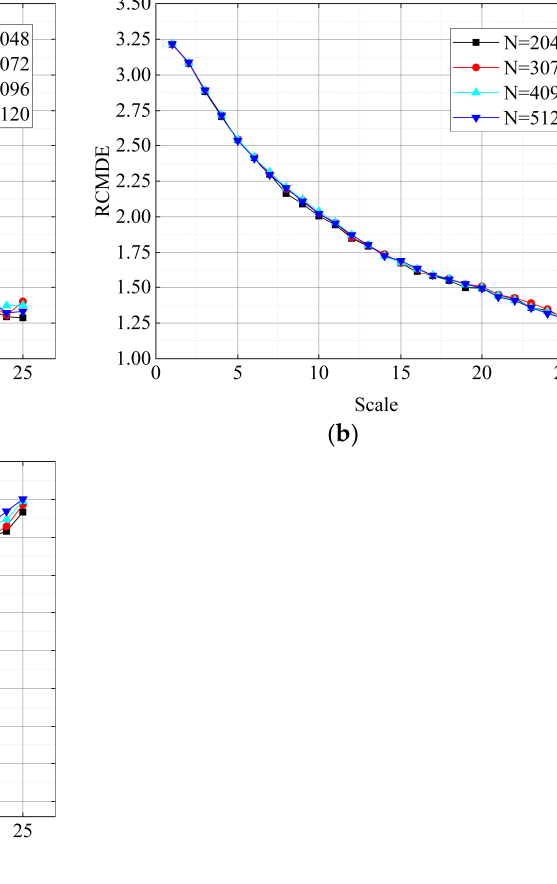
Table 1. The comparison of computation time of three entropy values under different data lengths.